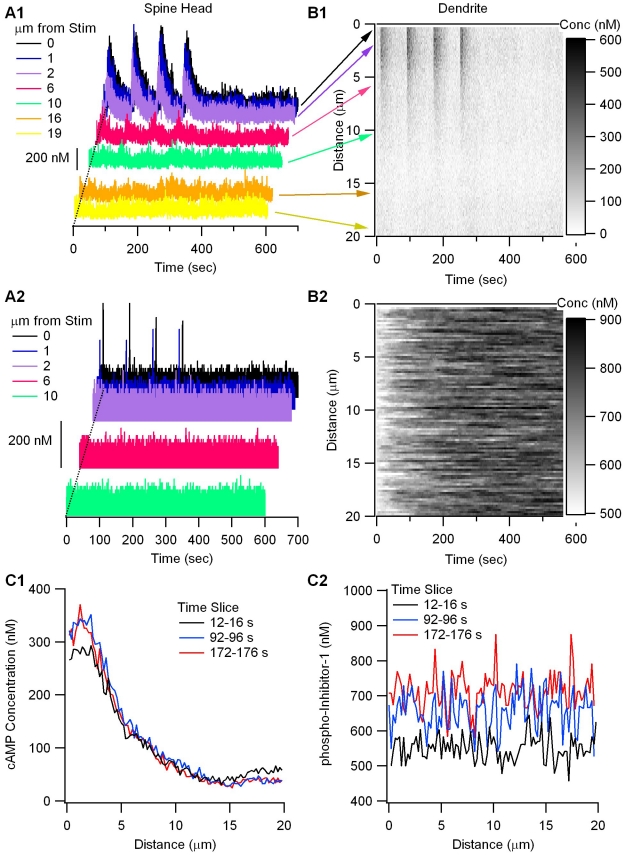
Spatial specificity of cAMP, but not PKA activity.(A) Concentration of cAMP (A1) and calcium (A2) in spines. Traces for the stimulated spines are toward the back; not all spines are illustrated. The concentration is highest in the stimulated and adjacent spines. (B) Concentration of cAMP and phospho-inhibitor versus time and space. The y-axis has been flipped, with 0 µm at the top to enhance correspondence with (A). Concentration is indicated by scale bar on the right. (B1) shows that cAMP exhibits spatial specificity. Arrows from traces in A1 to y-axis of B1 demonstrates spatial correspondence. (B2) shows that phospho-inhibitor-1 does not exhibit spatial specificity at this scale. (C) Time slices shortly after the stimulation at 10 s, 90 s and 170 s plotted against distance from the stimulated end of the dendrite. (C1) cAMP concentration exhibits spatial specificity, and does not increase with subsequent trains. (C2) Phospho-inhibitor-1 increases with subsequent trains, but does not exhibit spatial specificity.